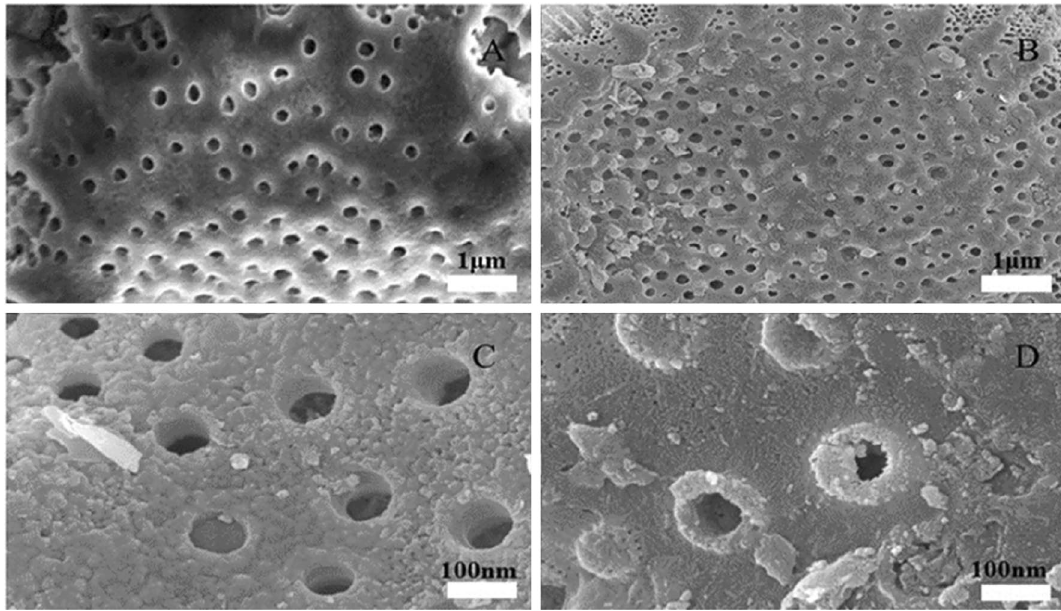
Figure 1. SEM images of DA and Al-DA before and after adsorption. ( A ) Before DA adsorption. ( B ) After DA adsorption. ( C ) Before Al-DA adsorption. ( D ) After Al-DA